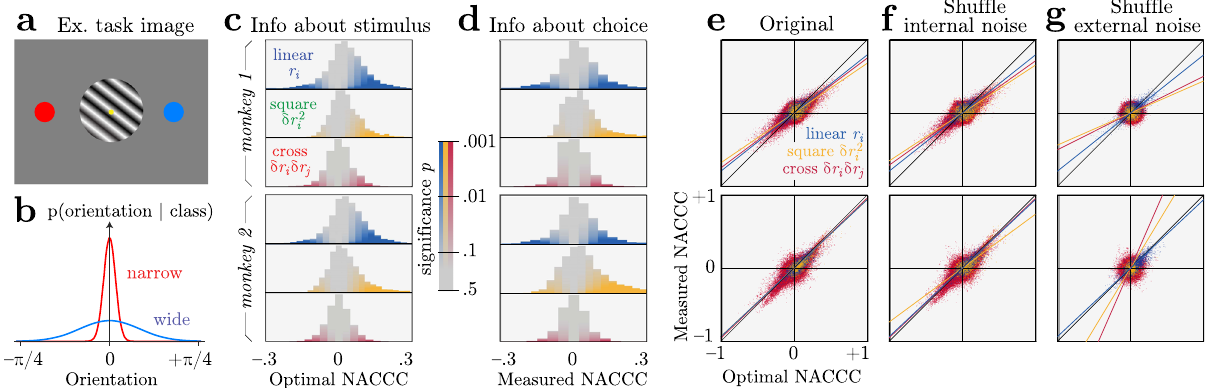
Fig. 6 Nonlinear information and choice correlations in a variance discrimination task, for neural data from two monkeys. a Example oriented grating and saccade targets. b The orientations of the gratings were drawn from a narrow or wide distribution, and the monkey had to guess which by saccading to the appropriate target. c Neurons contain linear and nonlinear information about the task variable. This is revealed by the Normalized Average Conditional Choice Correlations (NACCC, Eq. (17)) predicted for optimal decoding, which are proportional to the measured signal-to-noise ratios (Eq. (7)) for each neural response pattern (blue r i , green δ r 2 i , red δ r i δ r j ). Color saturation indicates statistical signi fi cance (see the “ Methods ” subsection “ Application